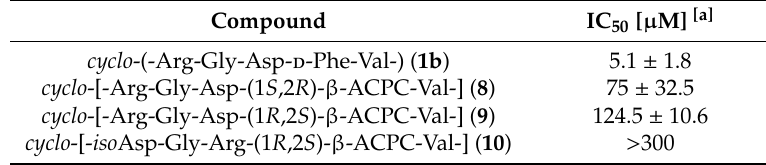
Table 2. IC 50 values of the cyclic peptides as determined by cell adhesion assays with WM115 cells.